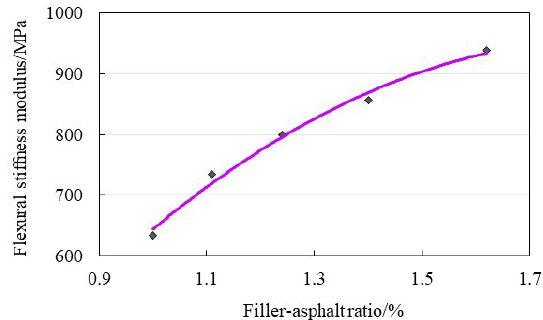
Figure 11. Relationship between flexural stiffness modulus and filler-asphalt ratio of SMA- Ⅱ -3 mixture at −10 °C, loading rate of 50 mm/min.